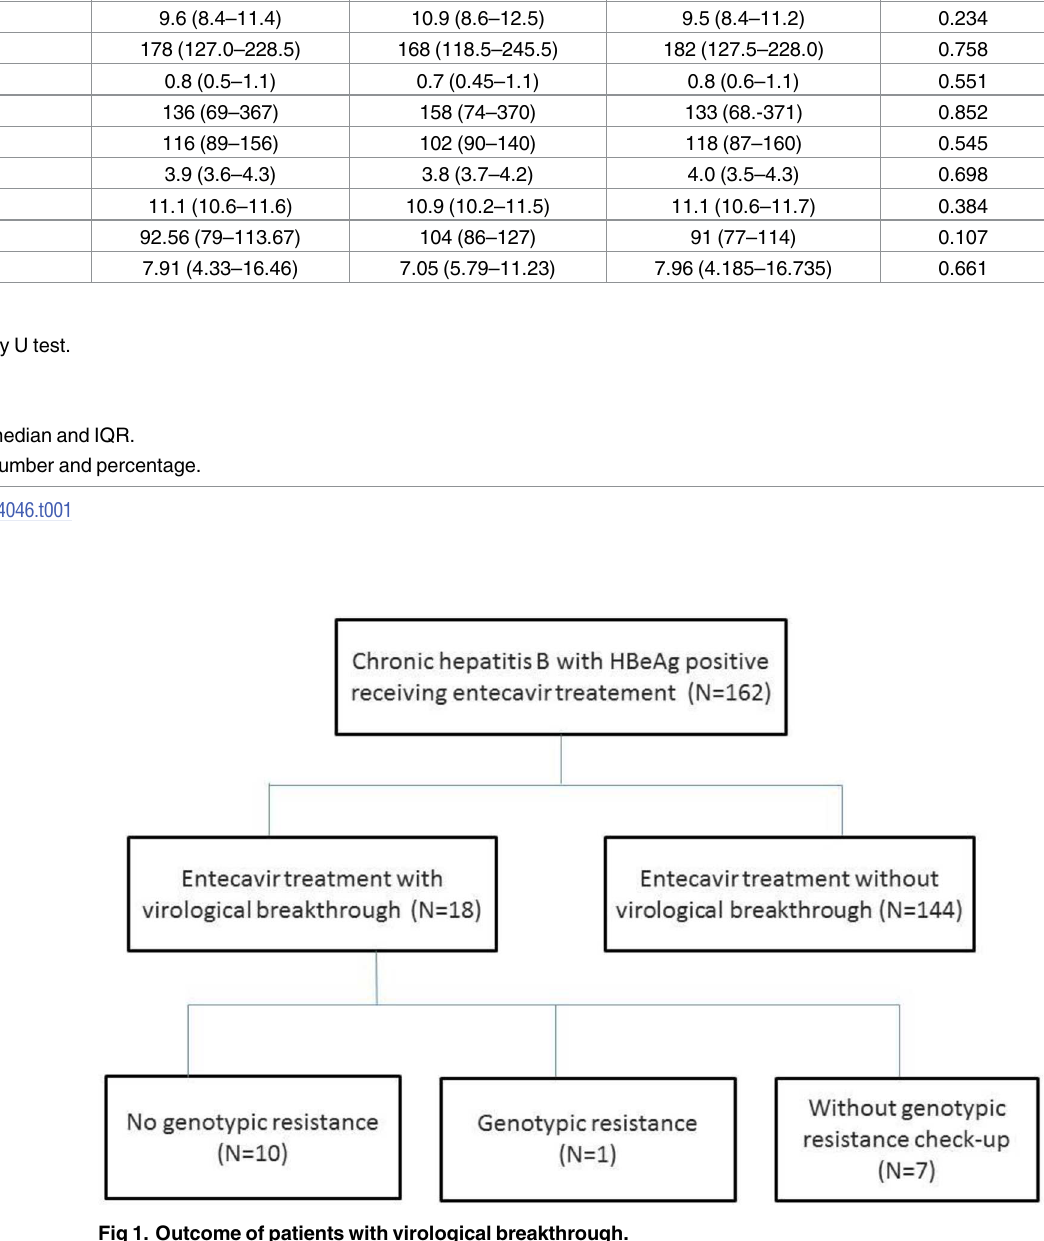
Fig 1. Outcome of patients with virological